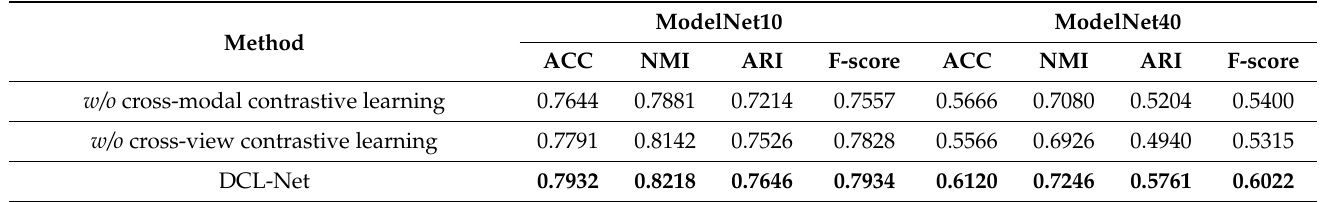
Table 3. The evaluation of the cross-view and cross-modal contrastive